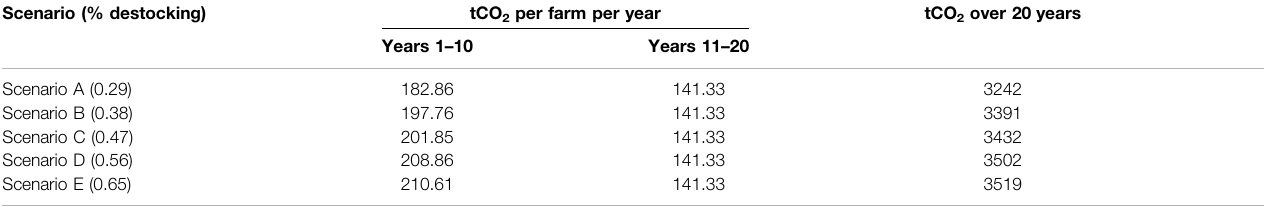
TABLE 4 | Estimated carbon bene fi ts for the household modeled from adoption of grassland management practices in each scenario (tonnes of carbon dioxide, tCO 2 ). Scenario (% destocking)